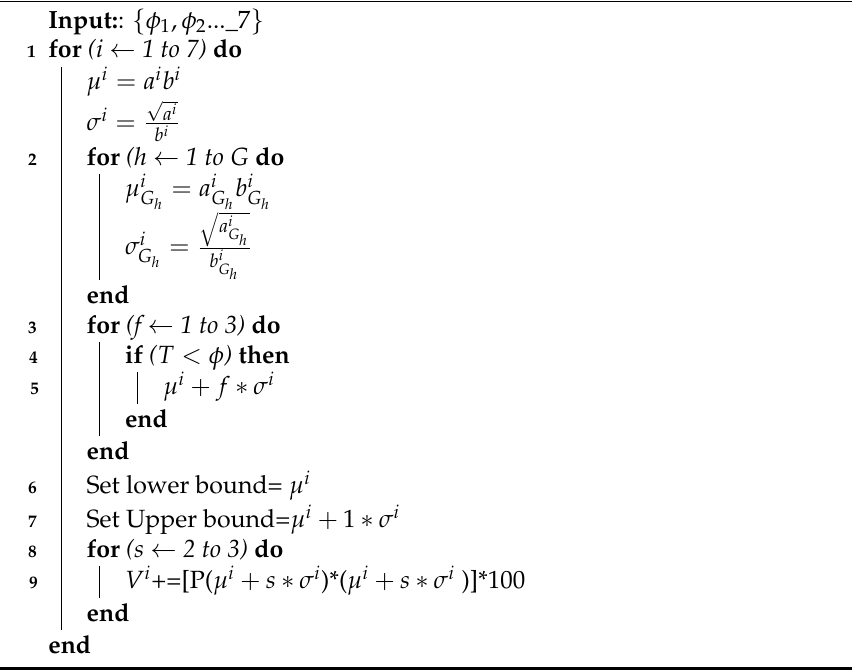
Algorithm 3: Data driven analysis using probability distribution